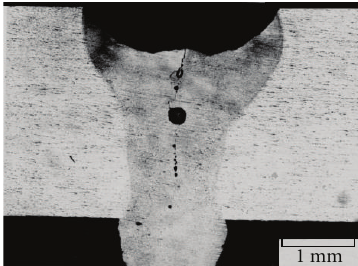
Figure 4: Fusion zone configuration of alloy AA6061 made using P = 5kW, S = 4m/min, Dd = 0, 15l/min argon.